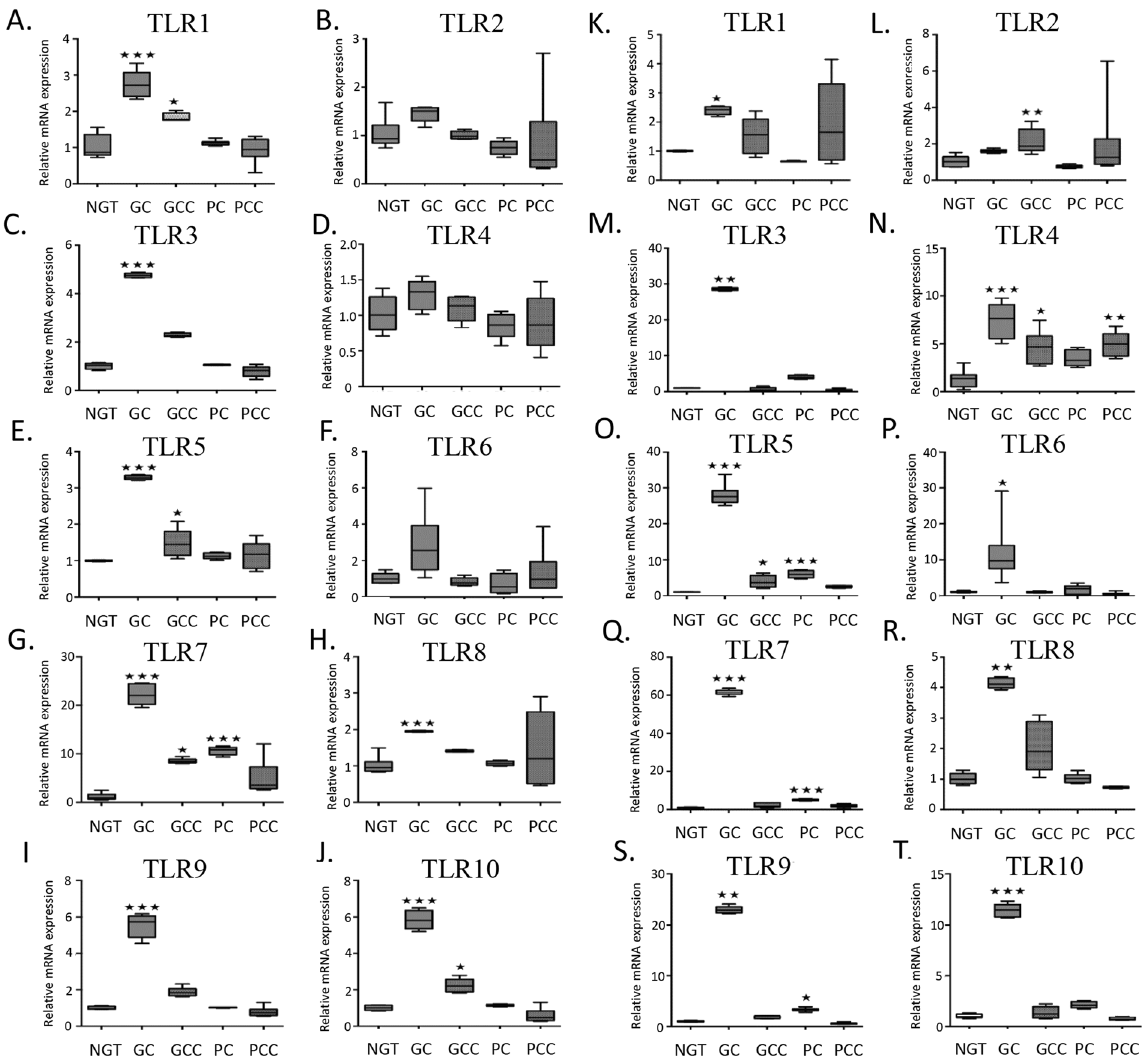
Figure 3. Gene expression of TLR1-10 in monocytes and neutrophils from NGT and T2DM patients. Analysis of TLR1 ( A , K ), TLR2 ( B , L ), TLR3 ( C , M ), TLR4 ( D , N ), TLR5 ( E , O ), TLR6 ( F , P ), TLR7 ( G ,Q), TLR8 ( H , R ), TLR9 ( I , S ), TLR10 ( J , T ) gene expression in monocytes ( A – J ) and neutrophils ( K – T ) from NGT and T2DM patients (n = 8 per group). Top and bottom horizontal lines of the boxplots indicate 25th and 75 th percentiles respectively; lines within the box indicate median values. * p < 0.05, ** p < 0.01, *** p < 0.001 vs